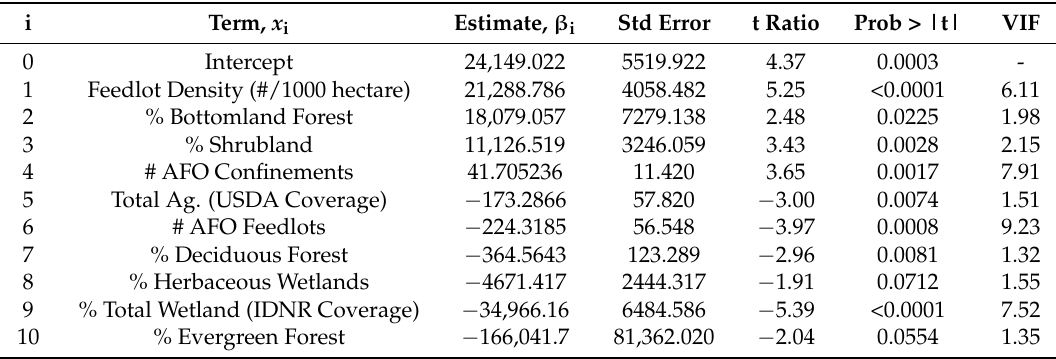
Table 2. Model Parameter